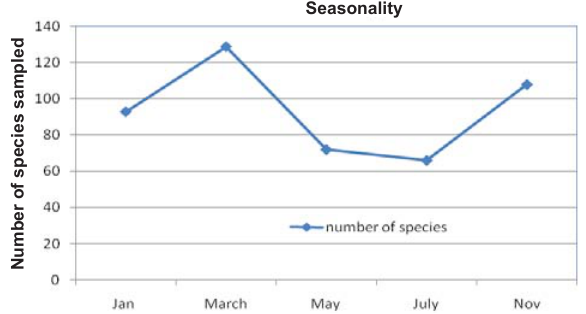
Figure 3. Seasonal variation in number of butterfly species (pooled) in subtropical lowland forests of Bhutan (January 2009–March 2010).